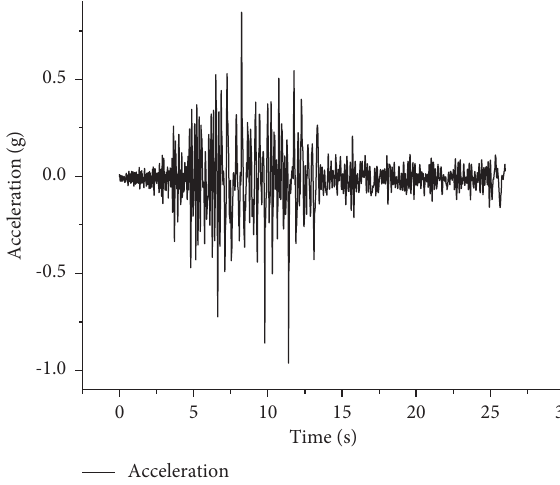
Figure 11: Time history of the input wave of the numerical simulation.